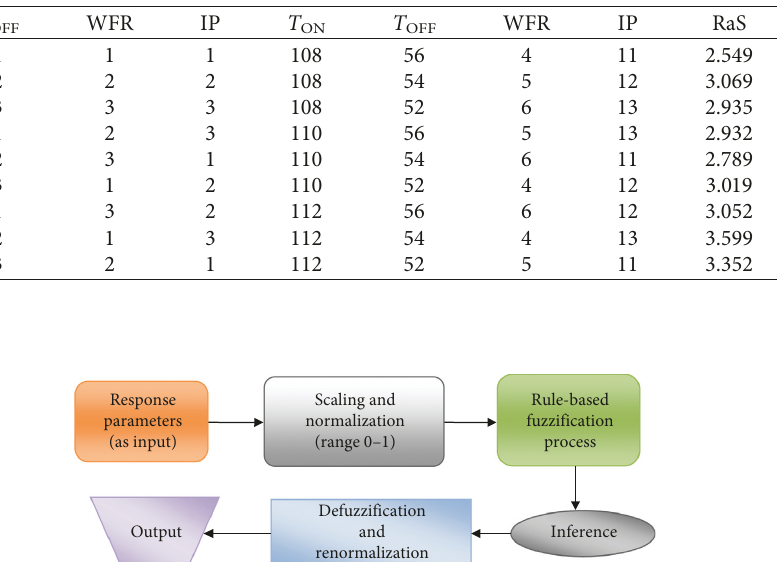
Table 4: Taguchi’s L 9 orthogonal array (OA’S) for experimentation and experimental results.